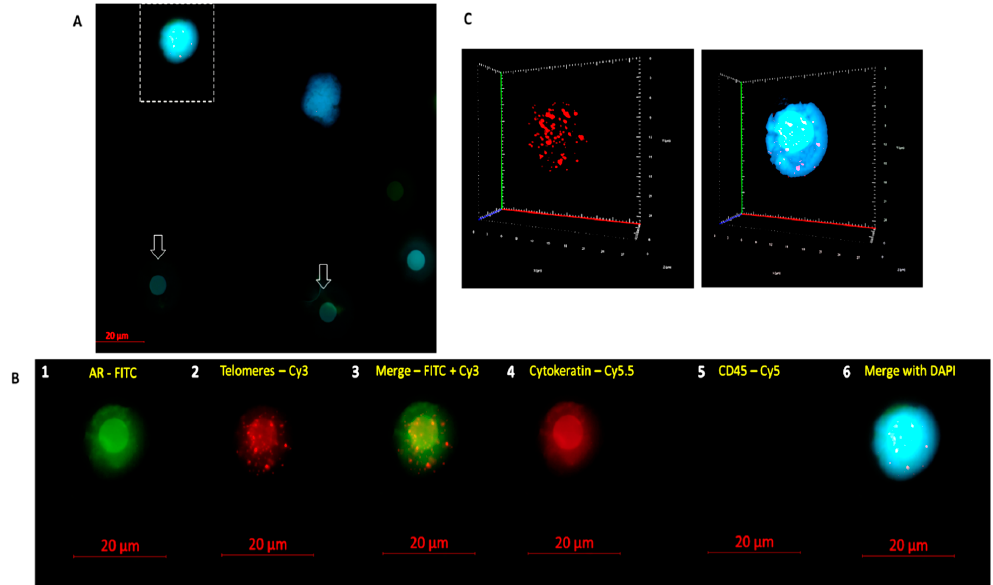
Figure 2. Example of a circulating tumor cell from a high-risk localized prostate cancer patient captured on top of a filter pore ( A ). The arrows show empty filter pores in A. Prostate cancer CTCs are recognized based on their androgen receptor (AR) and cytokeratin-positive staining and -negative staining of CD45 ( B ). (B1) Two-dimensional image showing a CTC AR positive in fluorescein isothiocyanate (FITC—green); (B2) CTC with the telomeres labeled with Cy3-labeled probe (red); (B3) Merge between FITC and telomeres; (B4) CTC cytokeratin positive in Cy5.5 (red); (B5) CTC CD45 negative; and (B6) merge of CTC counterstained with 4 (cid:48) ,6-diamidino-2-phenylindole (DAPI) in blue. In ( C ), the same cell is shown in three-dimensional representation. Red spots represent telomere signals; and the blue is